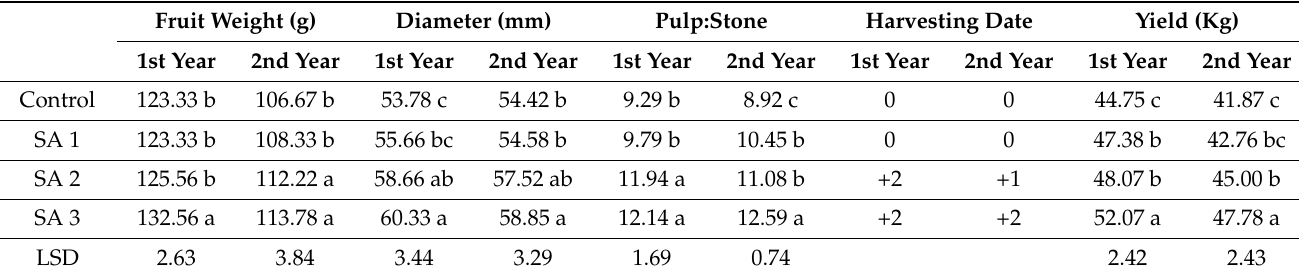
Table 1. Effects of different pre-harvest treatments of SA on the peach fruit physical characteristics at harvest in the 1st and 2nd years.